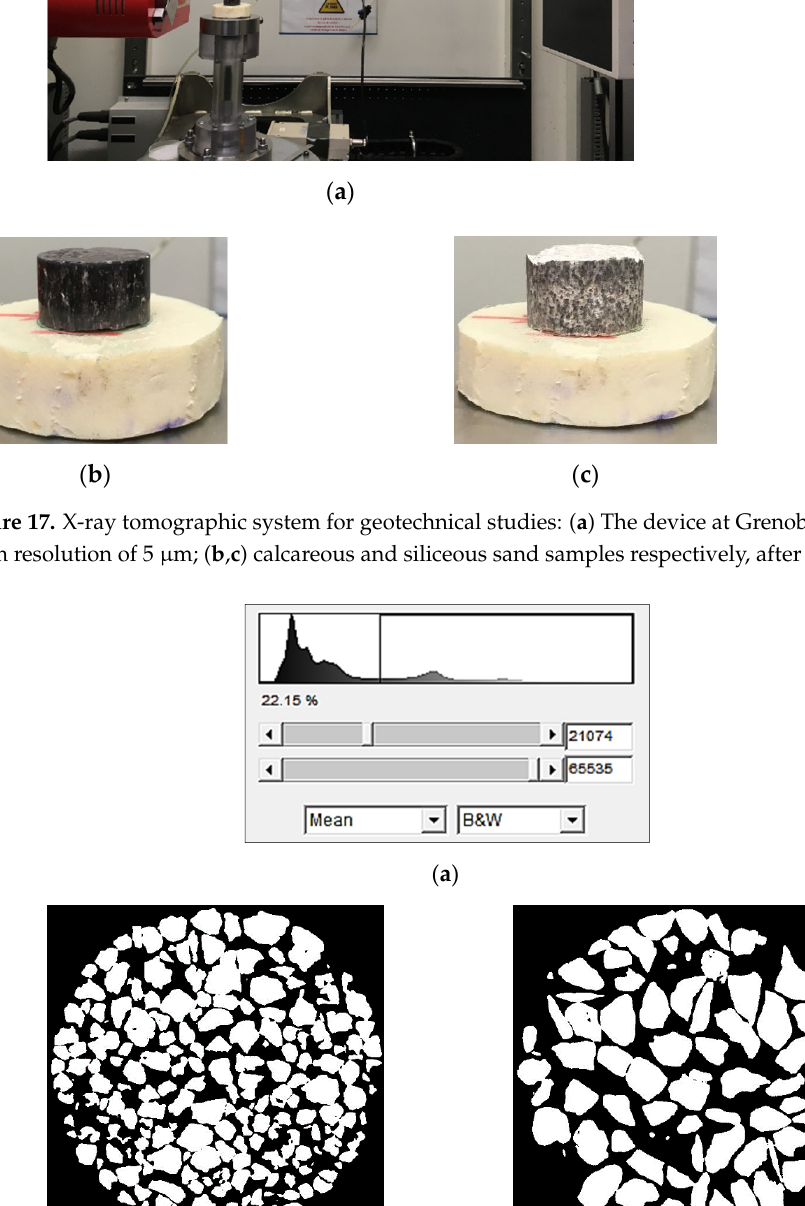
Figure 17. X-ray tomographic system for geotechnical studies: ( a ) The device at Grenoble has a max- imum resolution of 5 µm; ( b , c ) calcareous and siliceous sand samples respectively, after compres- sion.